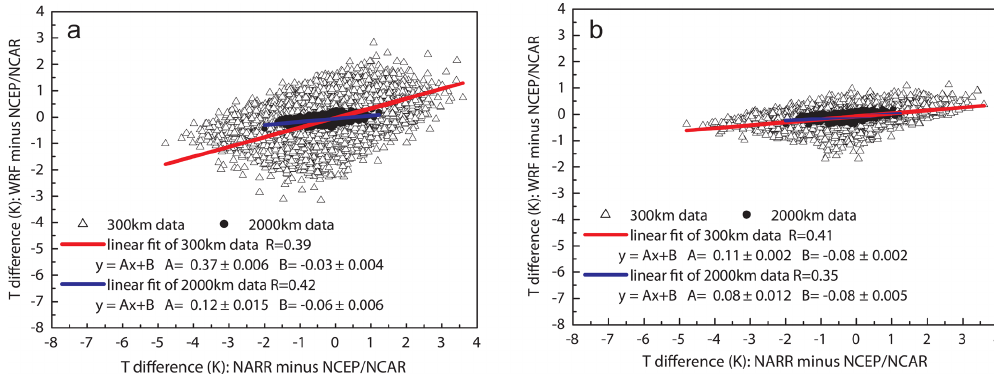
Fig. 2. Correlation for the temperature anomaly from NCEP/NCAR data at 500hpa, 2000km and 300km scales for July 2009 with linear regression of 95% confidence. (a) anomaly of WRF output by spectral nudging vs. anomaly of NARR data; (b) anomaly of WRF output by grid nudging vs anomaly of NARR